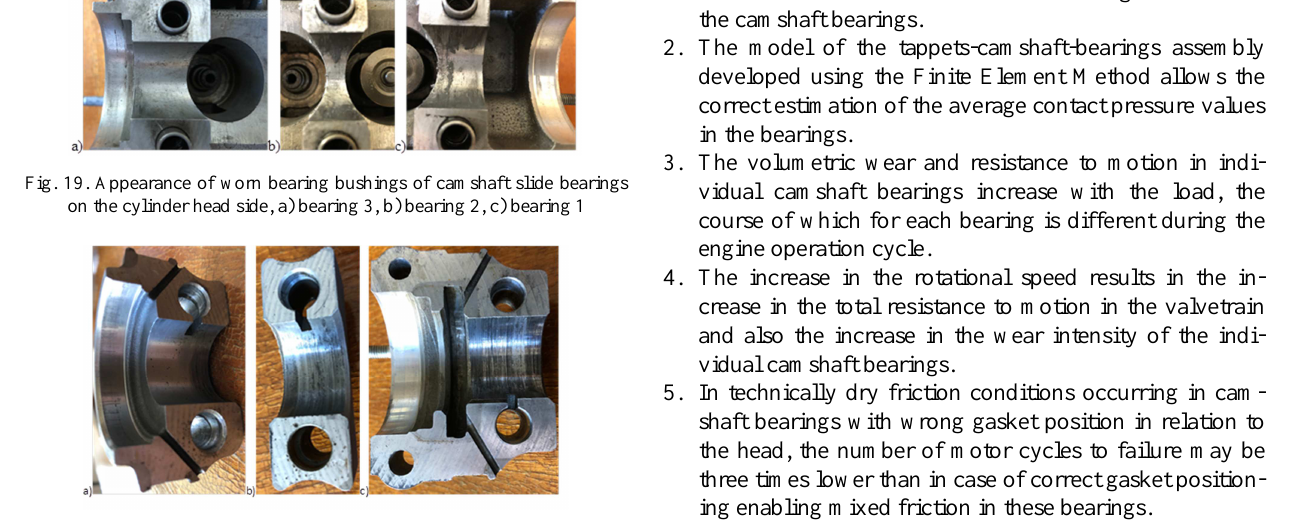
Fig. 20. Appearance of worn bearing bushings of cam roller bearings on the side of bearing covers, a) bearing 3, b) bearing 2, c) bearing 1